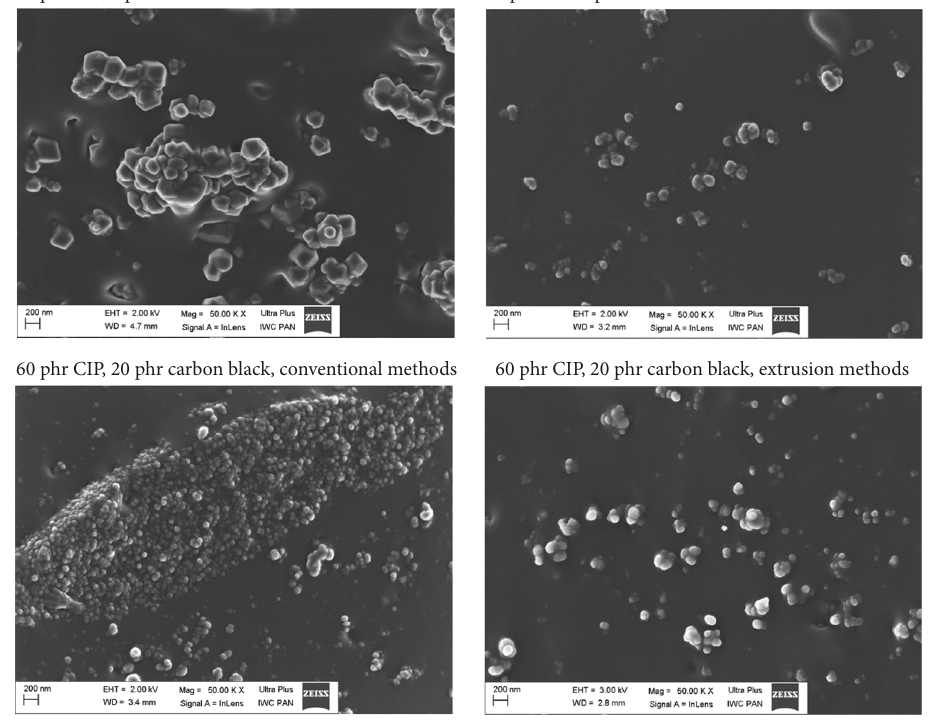
Figure 5: Morphological characteristics SEM image of composite filled with 60 phr CIP and 5 phr (up) and 20 phr (down) carbon black.